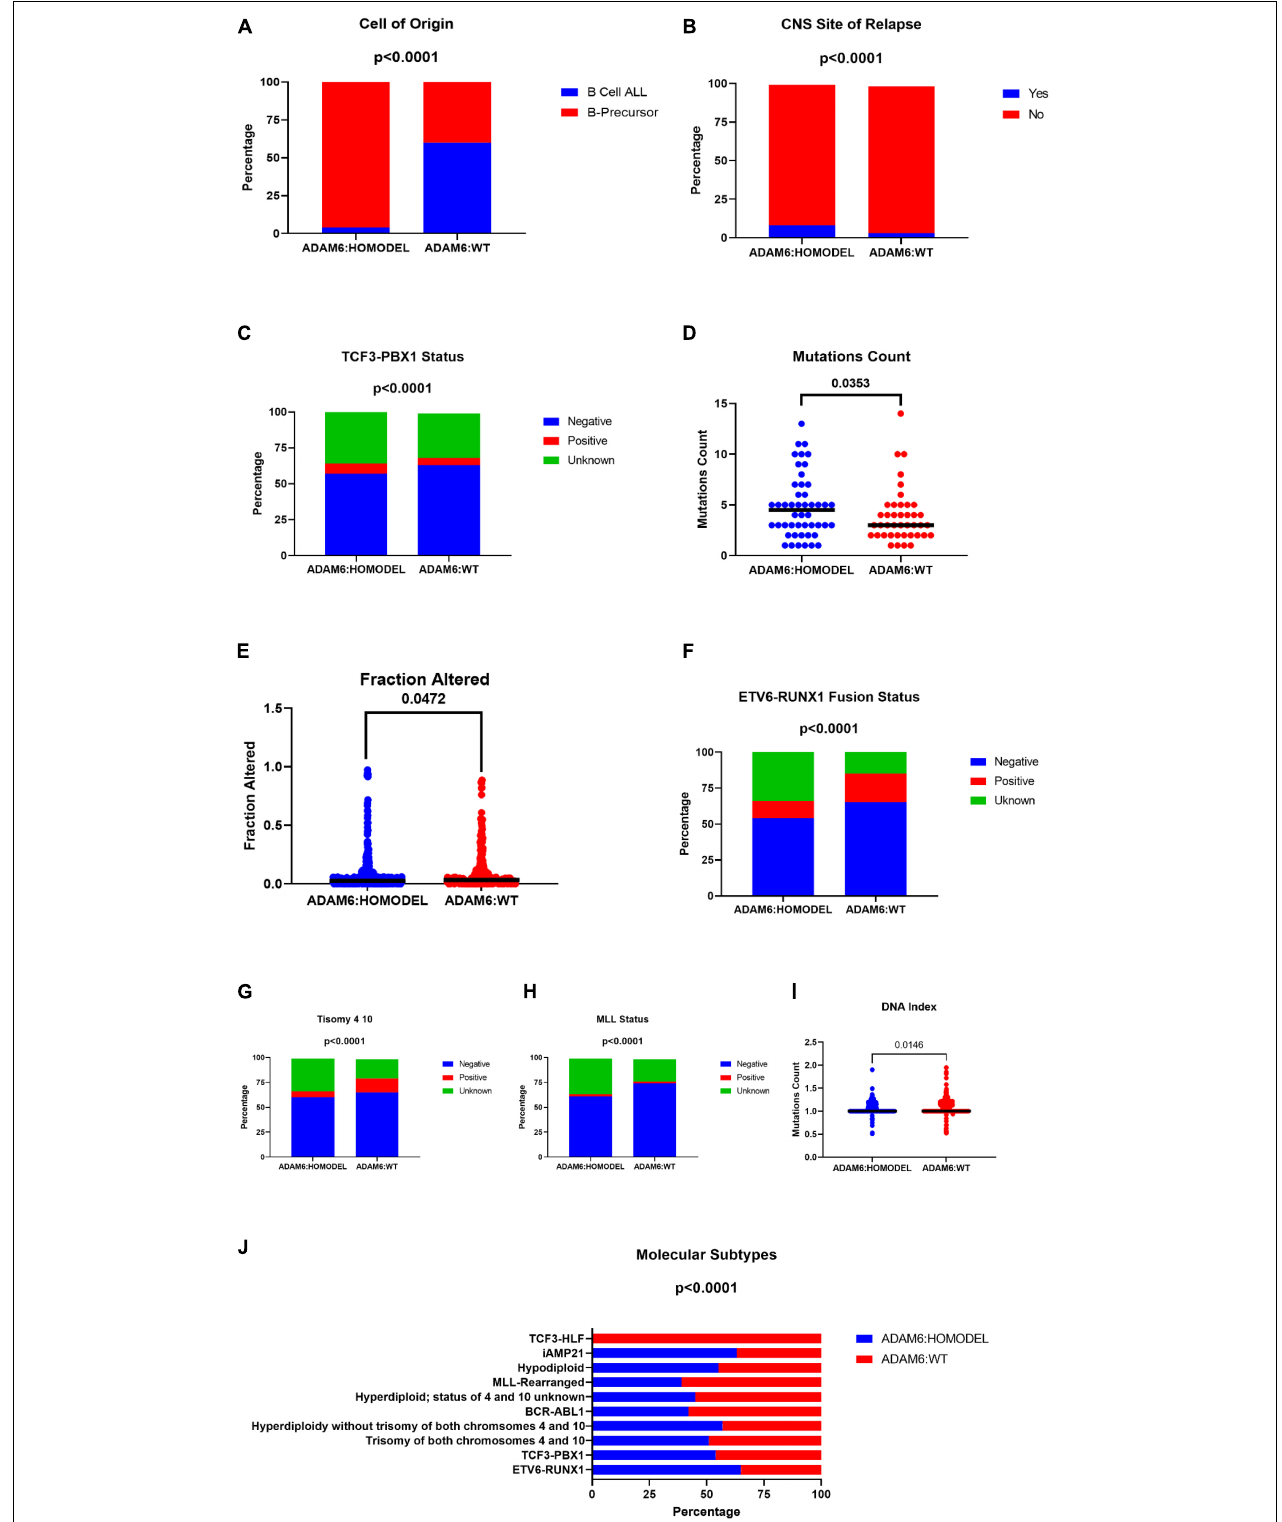
FIGURE 5 | Comparison of Molecular attributes of ADAM6 homozygous deletion (ADAM6:HOMDEL) versus ADAM6 wild-type (WT:ADAM6) patients.